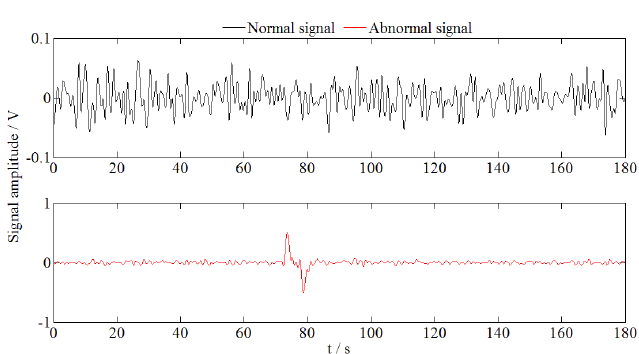
Figure 6. Time domain waveform of normal and abnormal acoustic signals.